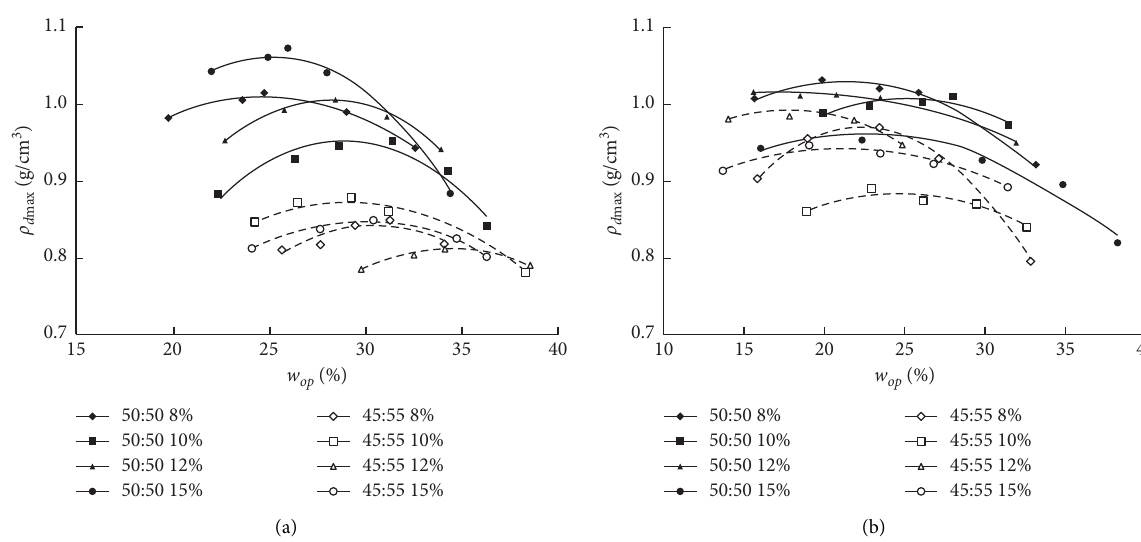
Figure 2: Results of compaction test and fitting curves: (a) muddy clay and (b) fine